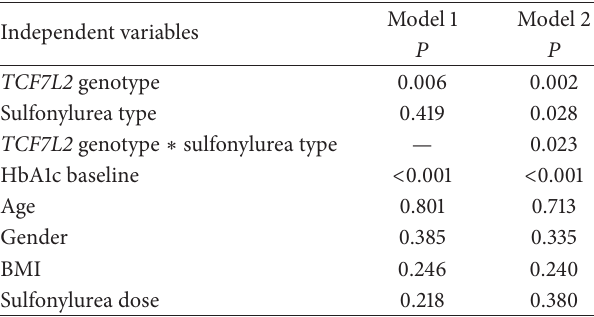
Table 4: Multivariate predictors of Δ HbA1c after sulfonylurea treat- ment.